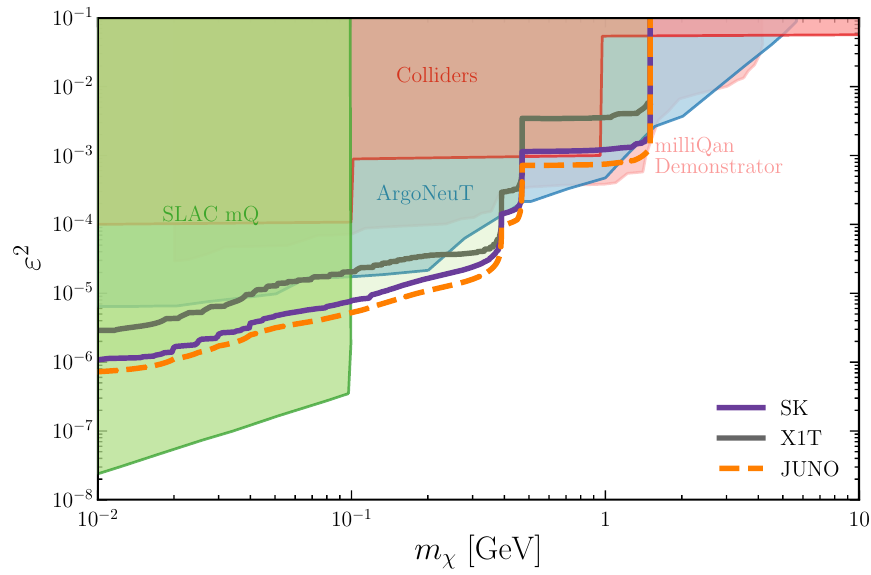
Figure 7 . Single-hit constraints on millicharged particles. Constraints on millicharged particle parameter space from SLAC mQ [72], ArgoNeuT [29], the milliQan Demonstrator [81], and collid- ers [78], compared with our 90% CL single-hit constraints from Super-Kamiokande (purple), JUNO (projection, orange), and XENON1T